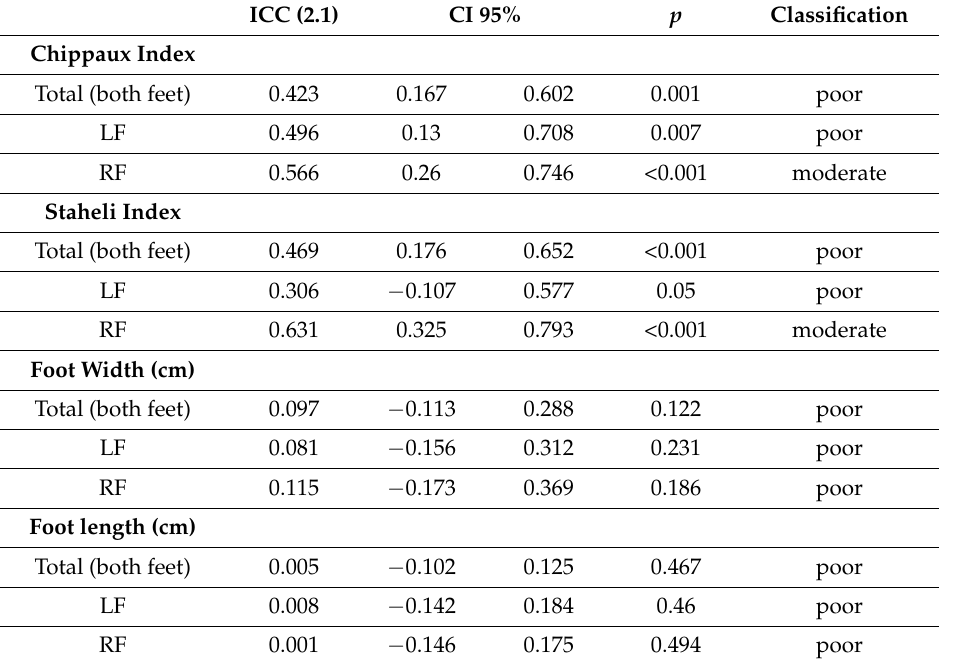
Table 3. Interclass correlations coefficients (ICC) for two raters (pedigraph and platform